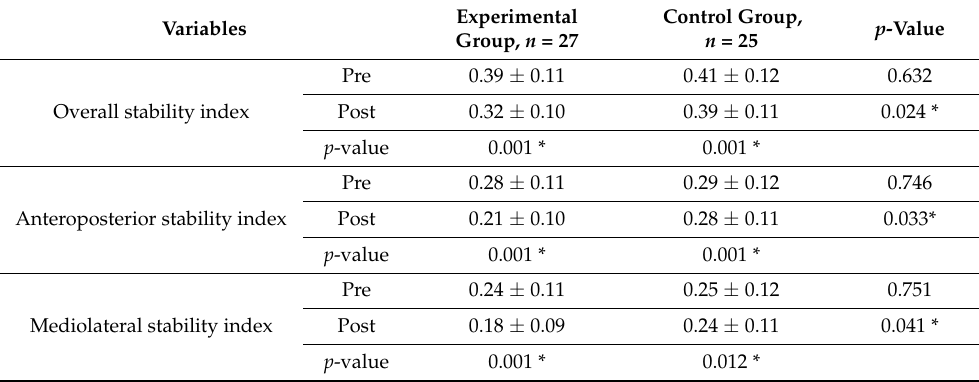
Table 3. Descriptive statistics of dynamic postural stability indices before and after intervention.